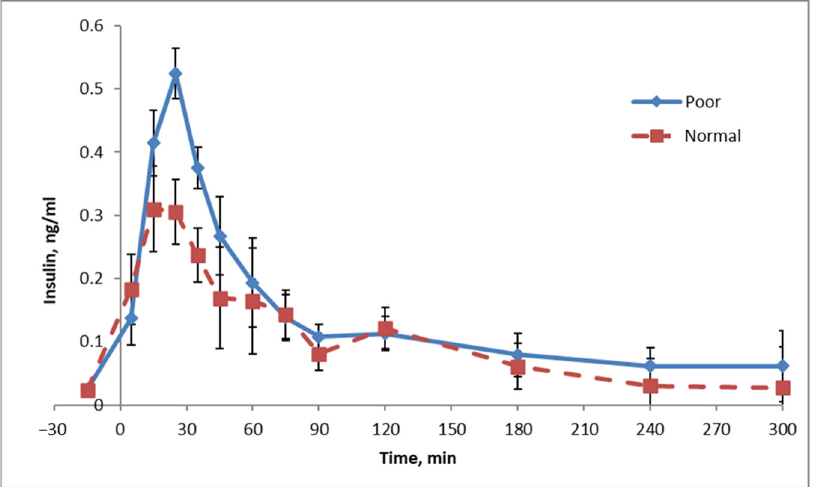
Figure 3. Insulin response to a glycemic challenge in piglets with a normal birth process and growth (‘Normal’) or with a birth process hampered by dystocia and, subsequently, poor growth (‘Poor’) [13].